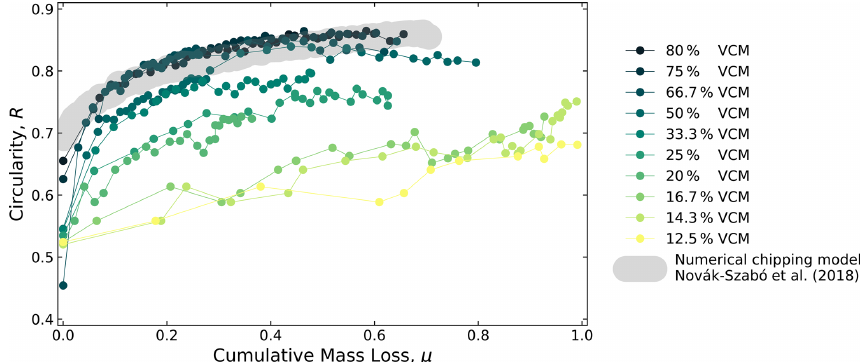
Figure 10. Circularity as a function of cumulative mass loss for all material strengths tested, where circularity measurements are averaged for all particles of a given composition ( n = 5). Mechanically strong particles (50%–80% VCM) with A b ≤ 0 . 013s 2 m − 2 fall within the pure chipping regime and conform to the universal curve described by Novák-Szabó et al. (2018), which is identified by the gray